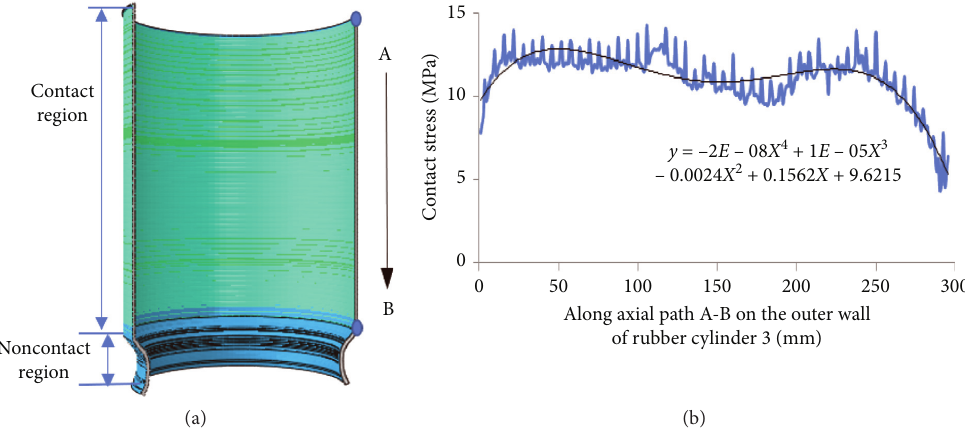
Figure 13: Contact stress variation in the rubber cylinder 3 and the average contact stress along the axial path on the outer wall of the rubber cylinder during the